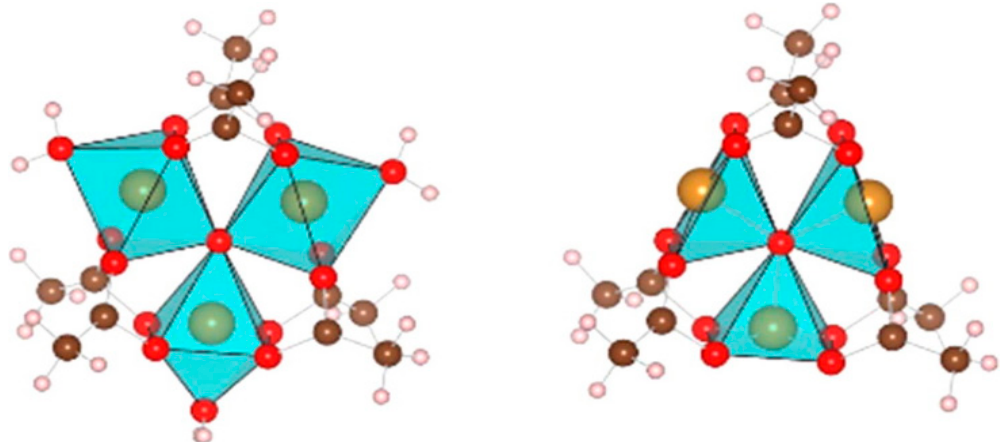
Figure 1. Acetate model of the structure of iron benzene-1,3,5-tricarboxylate (Fe-BTC), where iron atoms are inside the polyhedra. Oxygen = red, carbon = brown, and hydrogen = white. Left panel: hydrated form, right panel: dehydrated form. Reprinted with permission from [12]. Copyright 2015 American Chemical Society.